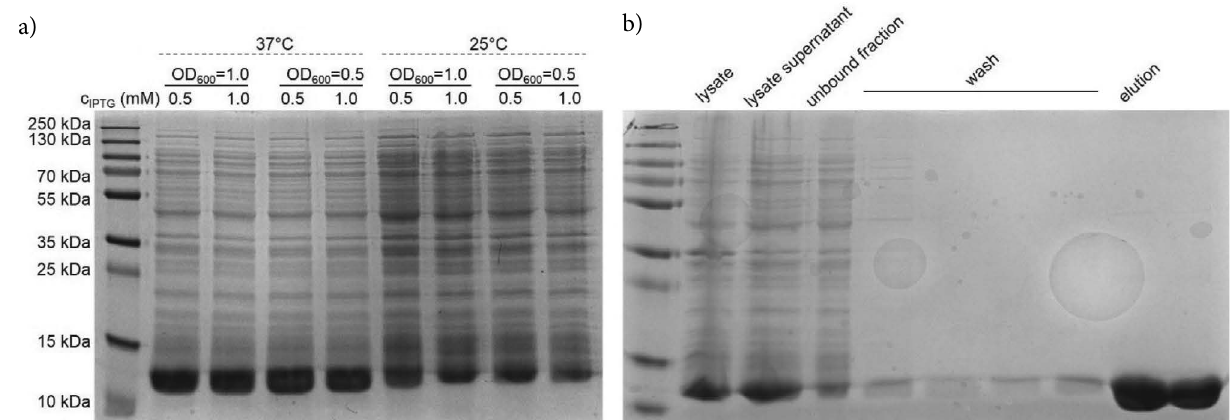
Fig. 2. Coomassie-stained SDS-PAGE of E. coli expressing SpyTag-B domain under different culturing conditions (A) and fractions obtained after IMAC purification of SpyTag-B domain from cell lysate